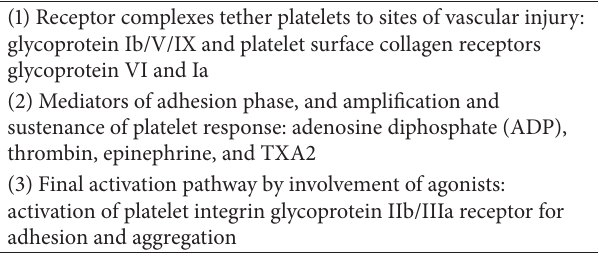
Table 1: Select steps in platelet activation